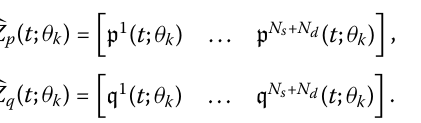
puts, pressure at the N s supply boundary nodes and mass-flux at the N d demand bound- (cid:26) Y ∗ ( t ; θ k ) are computed for perturbations in the ary nodes, while the output trajectories respective N ∗ steady-state components. Using the dual state trajectories is significantly faster than output trajectories, as computing observability as dual reachability scales, as for the primal reachability, with the number of ports, instead of scaling with the number of internal states. The training parameters θ k are sampled from a sparse grid spanning the parameter space (cid:10) ⊂ R 2